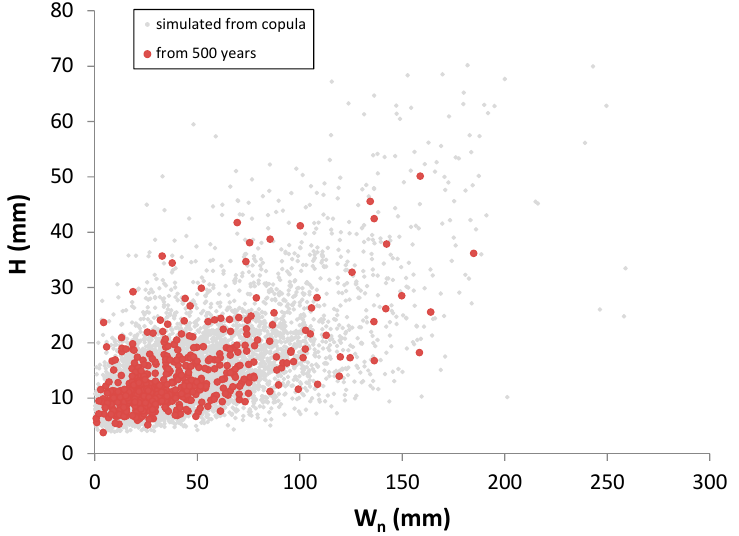
W (mm) n Figure 8 . Comparison among pairs of   hw n , derived from 500-year synthetic data, and 10,000 pairs Figure 8. Comparison among pairs of ( w n , h ) derived from 500-year synthetic data, and 10,000 pairs of   hw n , generated with the Monte Carlo method by the assumed bivariate distribution. of ( w n , h ) generated with the Monte Carlo method by the assumed bivariate distribution. Figure 8 . Comparison among pairs of   hw n , derived from 500-year synthetic data, and 10,000 pairs of   hw n , generated with the Monte Carlo method by the assumed bivariate distribution. , which provide the Through the RR model, it was possible to determine all the pairs   hw n flood quantiles Q 50 , Q 100 , and Q 200 . For each Q T , an envelope curve was obtained and compared with , which provide the Through the RR model, it was possible to determine all the pairs   hw n T = 50, 100, and 200 years, and with the the contour lines associated to the bivariate return periods flood quantiles Q 50 , Q 100 , and Q 200 . For each Q T , an envelope curve was obtained and compared with OR T = 50, 100, and 200 years, and with the , related to the classical univariate approach (Figure 9). pairs   hw the contour lines associated to the bivariate return periods n OR , related to the classical univariate approach (Figure 9). pairs   hw n